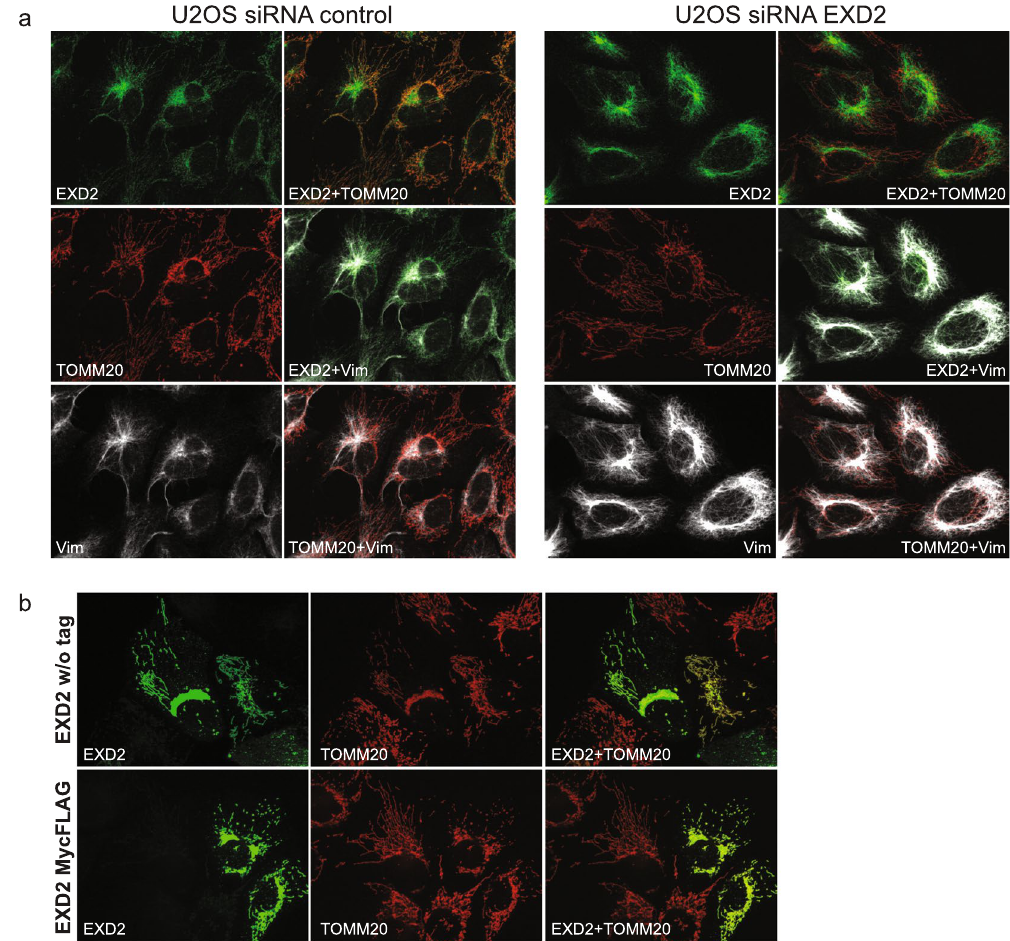
Figure 2. Knockdown or overexpression in U2OS cells of full-length EXD2 confirms the mitochondrial localization of EXD2. ProteinAtlas describes their EXD2 antibody, which we have used throughout this study, as having a mitochondrial and possible intermediate filament localization. To test the localization and the validity of their antibody we tested the EXD2 antibody, together with an antibody against the outer-membrane protein Tomm20 and an antibody against the intermediate filament protein vimentin (Vim) using immunofluorescence following transfection with either a pool of non-targeting control siRNAs or a pool of three EXD2 Stealth siRNAs (panel a). Co-staining in control siRNA cells with Tomm20 and vimentin shows co-localization of the EXD2 signal both with mitochondrial and intermediate filament signals. EXD2 siRNA treatment shows that while the EXD2 mitochondrial signal is no longer observed, the intermediate filament signal remains suggesting that this signal is either non-specific or that the siRNA pool used does not affect intermediate filament associated EXD2. Transient overexpression of the predicted full length protein, either w/o a tag or with a C-terminal combined Myc/FLAG tag shows an exclusive mitochondrial localization of the protein as illustrated by Tomm20 co-staining, while higher level overexpression results in mitochondrial perinuclear clustering (panel b). With very high overexpression, the whole mitochondrial network collapsed in one large perinuclear cluster that had lost any typical mitochondrial network-like structure (Supplementary Fig. S1). Overexpressed full length EXD2 showed no evidence of either nuclear or intermediate filament localization. Please note that for this Figure images have been selected deliberately to best illustrate the mitochondrial localization of EXD2. Image views have thus been chosen showing cells with a clear and extended mitochondrial network, while trying to avoid cells with a condensed/collapsed mitochondrial